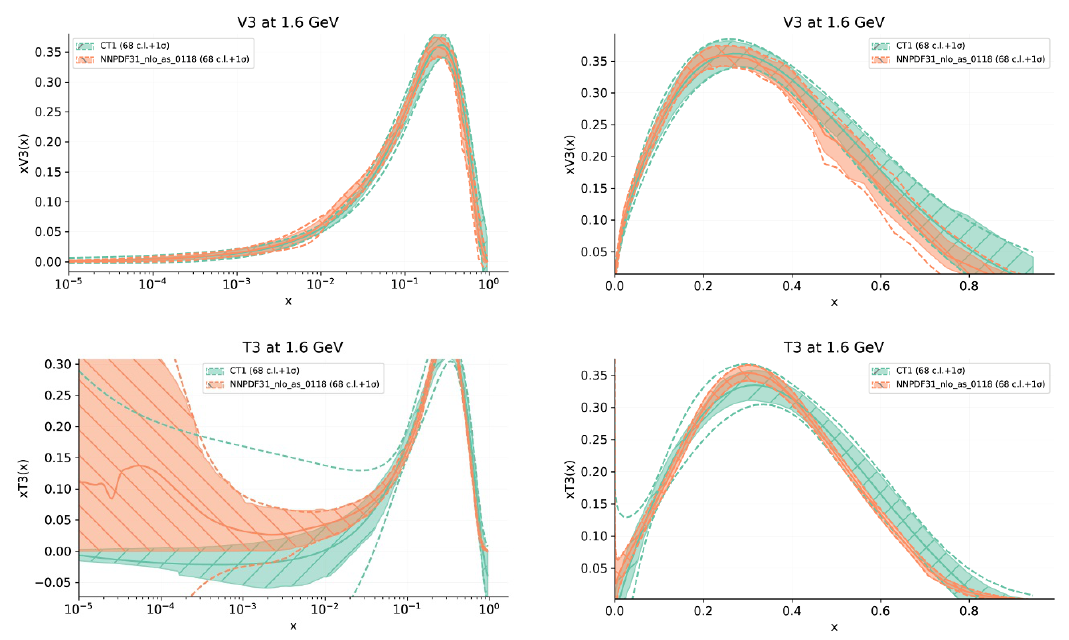
Figure 2 . Closure test (cid:12)t with (cid:12)xed small statistical error and no systematics (CT1) compared to the input PDFs set. V 3 (top line) and T 3 (lower line) combinations in linear and logarithmic scale are shown. The input PDFs set is fully reconstructed within 1-sigma level, getting PDFs with an error band comparable to the input